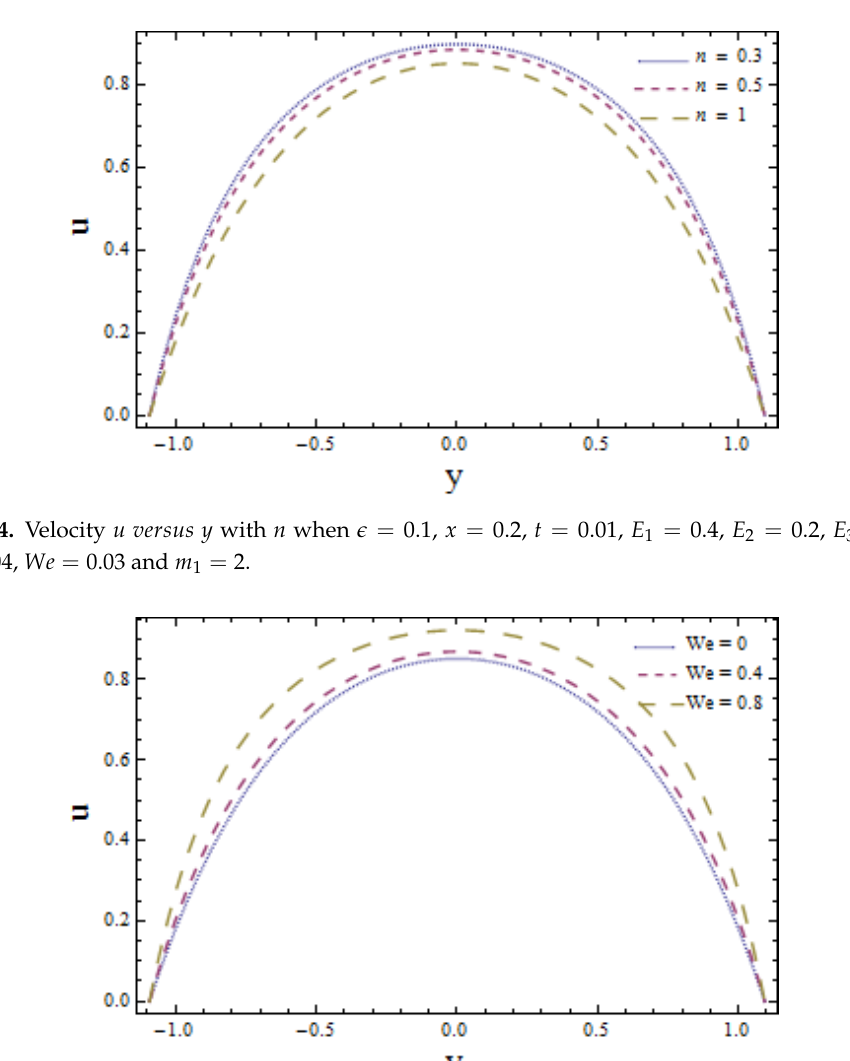
Figure 3. Velocity u versus y with m when x = 0.2, (cid:101) = 0.1, t = 0.01, E 1 = 0.4, E 2 = 0.2, E 3 = 0.3, We = 0.03, n = 0.4 and m 1 = 2.